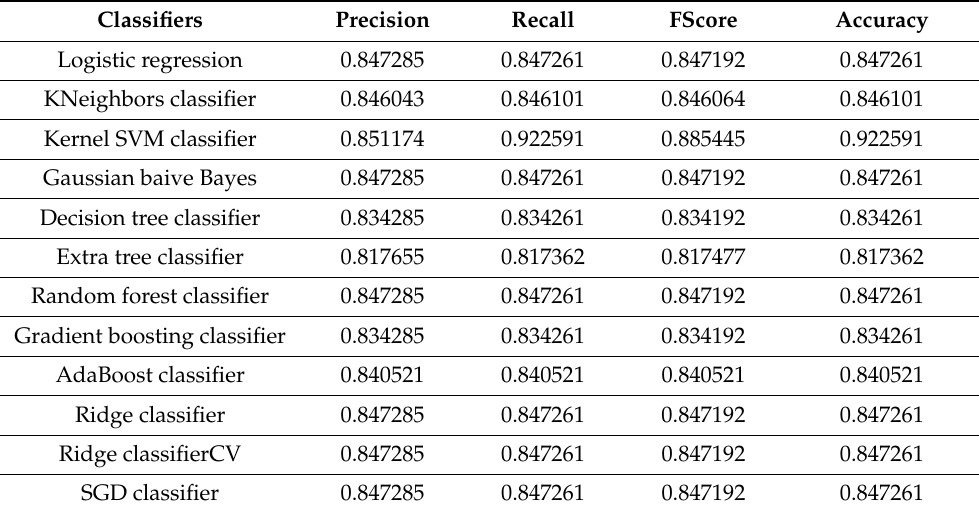
Table 3. Classification metrics after feature scaling.